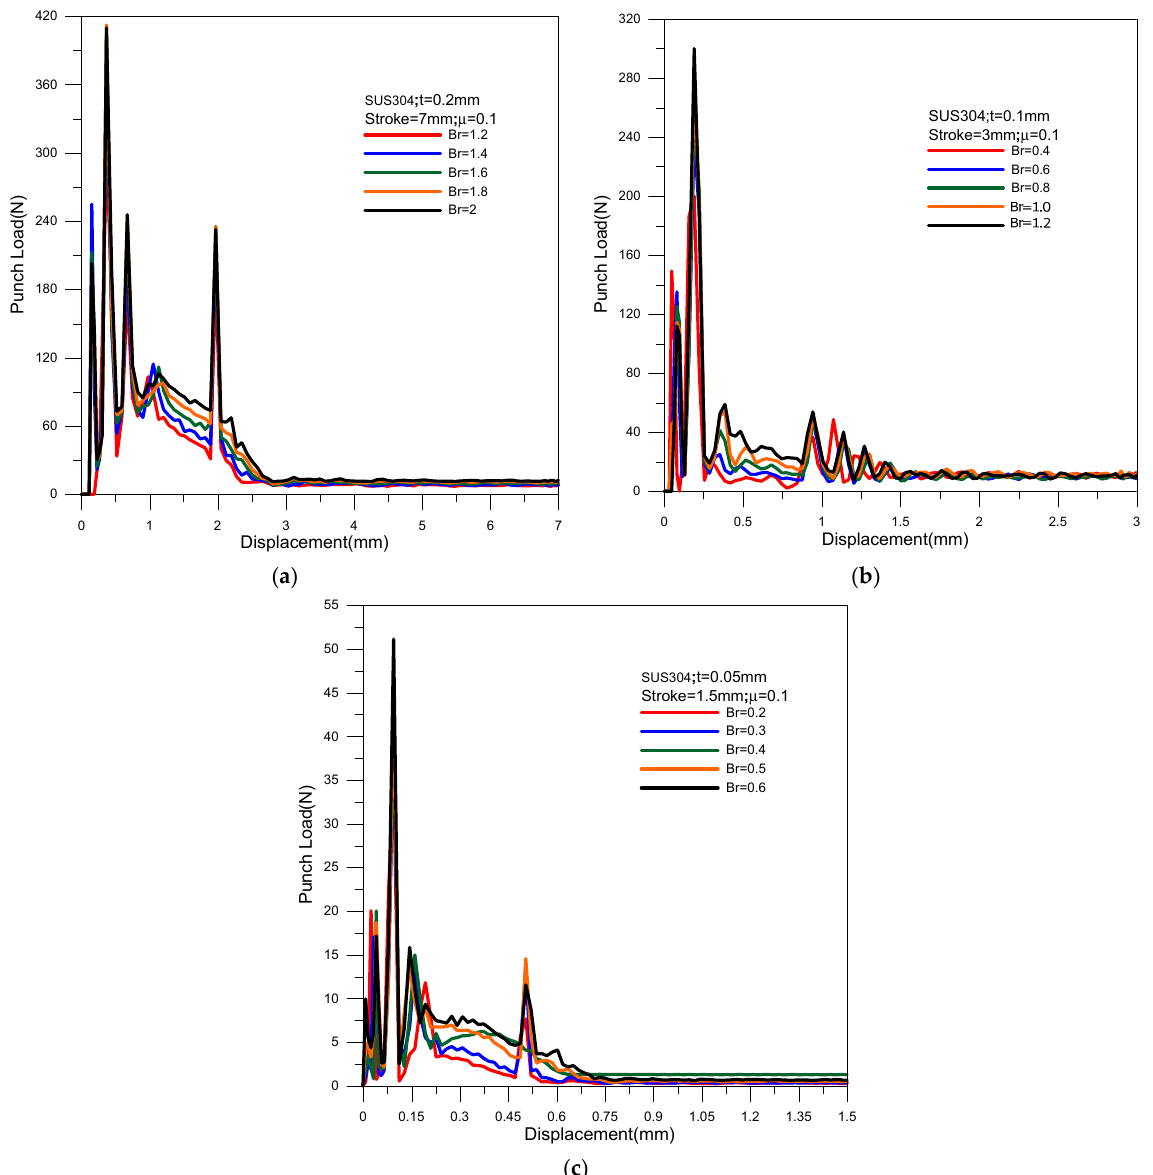
Figure 6. The relationship between the load and stroke of the punch with different values of Br: ( a ) Model 1; ( b ) Model 2; ( c ) Model 3.